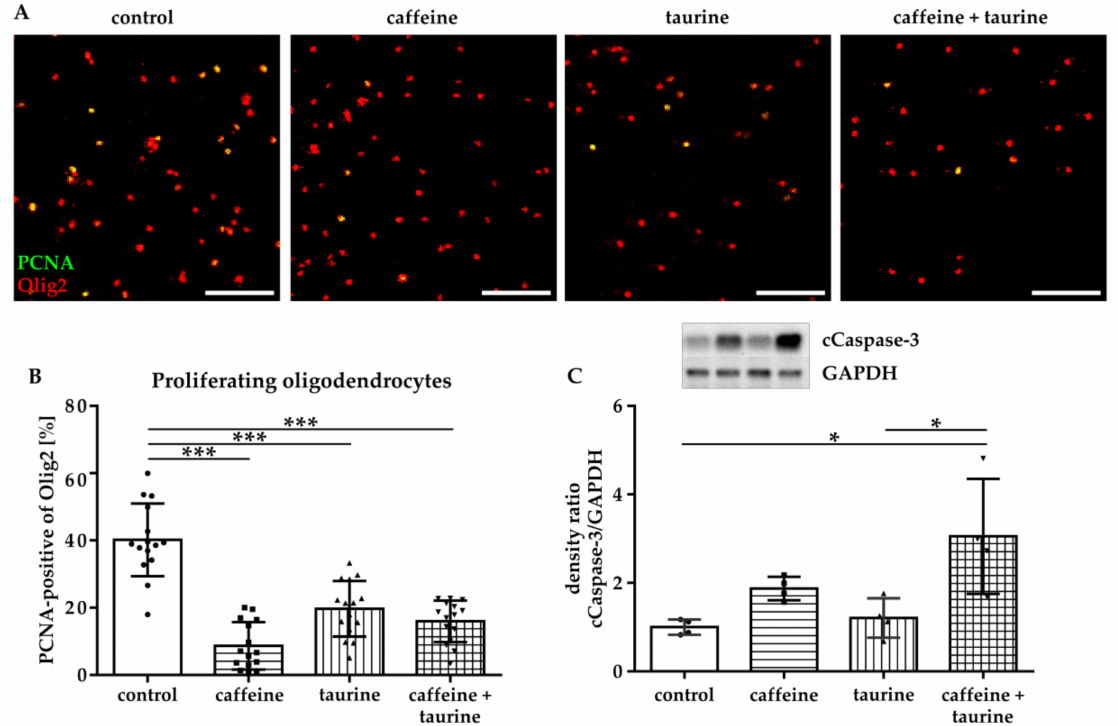
Figure 2. Immature oligodendrocyte cell loss is caused by a decreased proliferation and increased degeneration induced by caffeine and taurine. After treatment with or without 0.3 mg / mL caffeine and 4 mg / mL taurine alone or in combination, cells were analysed for proliferation via immunocytochemistry andforapoptosisviawesternblot. ( A )Representativeimagesofimmunofluorescencestainingofproliferating oligodendrocytes (PCNA green, Olig2 red). The number of proliferating oligodendrocytes was quantified in 15 images per group derived from three independent experiments ( B ) Scale bar 400 µ m. Ratio of cCaspase-3 and GAPDH protein expression was analyzed in protein lysates of cultured oligodendrocytes derived from four independent experiments ( C ), depicted by circle = control, square = caffeine, triangle up = taurine, triangle down = caffeine + taurine). * p < 0.05, *** p < 0.001, one-way ANOVA followed by a Bonferroni post hoc